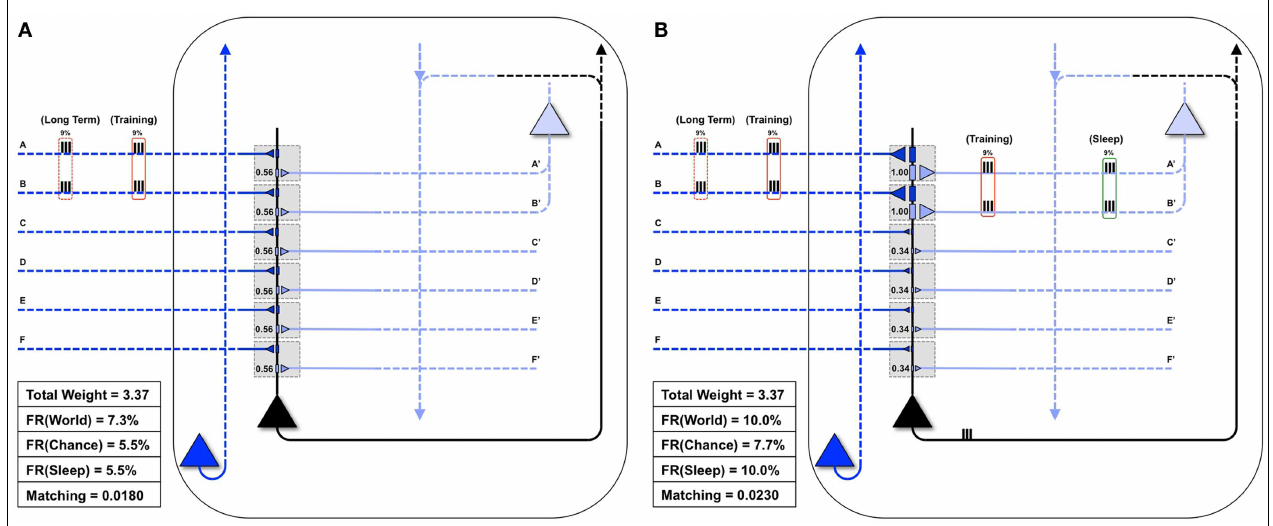
and thus will not see corresponding feedback on connections A (cid:48) and B (cid:48) . Matching for the “uniform” neuron is low. (B) Conversely, the “specialized” neuron is adapted to the coincident inputs AB, fires reliably when they are active, and receives corresponding feedback on connections A (cid:48) and B (cid:48) (as shown by the red Training box on its light blue connections). Furthermore, in Sleep , coincident activations corresponding to these strong connections will be much higher than by chance (9% of the time, as indicated by the green box on the right). Matching for the “specialized” neuron is